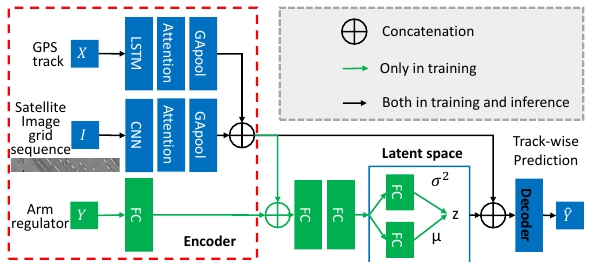
Figure 4. The structure of the CVAE-based model. The red box marks the encoding process. The black arrows indicate the steps done in both the training and the inference processes, while the green arrows indicate the steps done only in the training process.